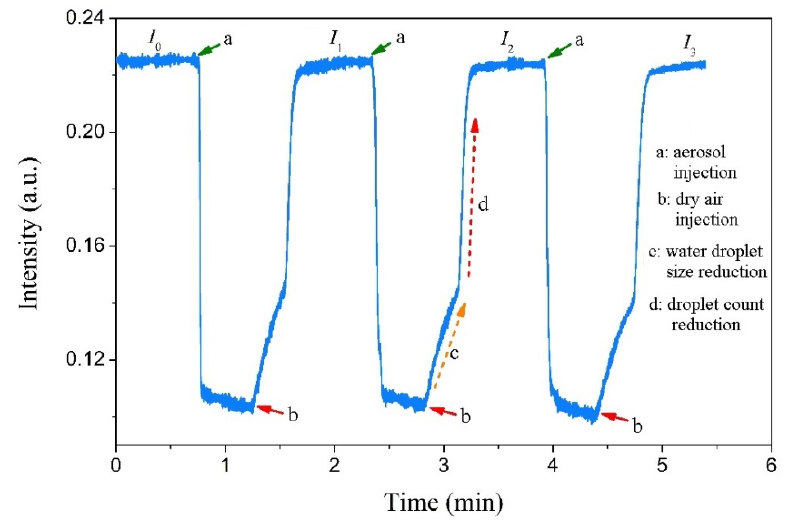
Figure 9. Changes in output light intensity measured upon step-by-step exposure of the COWG to the aerosol generated with pure water (with dry airflow injected for water droplet evaporation from the COWG after each exposure).